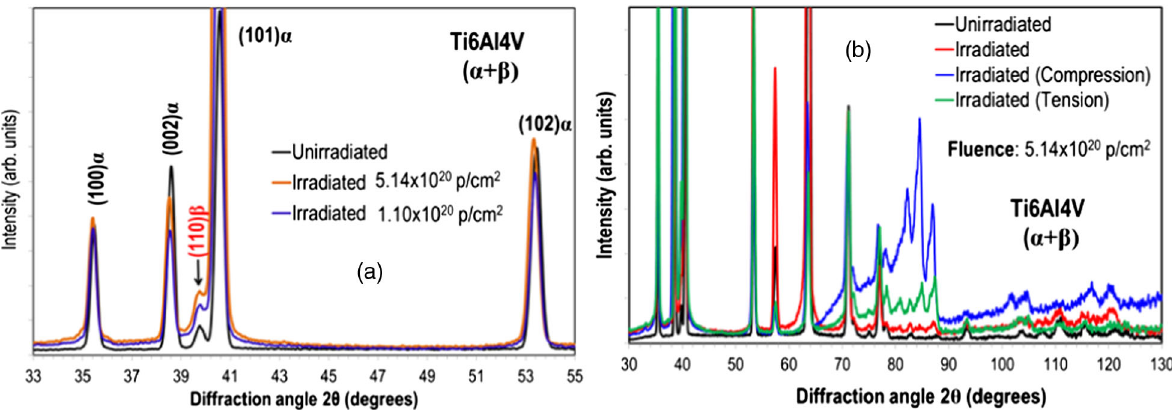
FIG. 22. Stability of α and β phases of Ti-6Al-4V following irradiation (a) and asymmetry between tension and